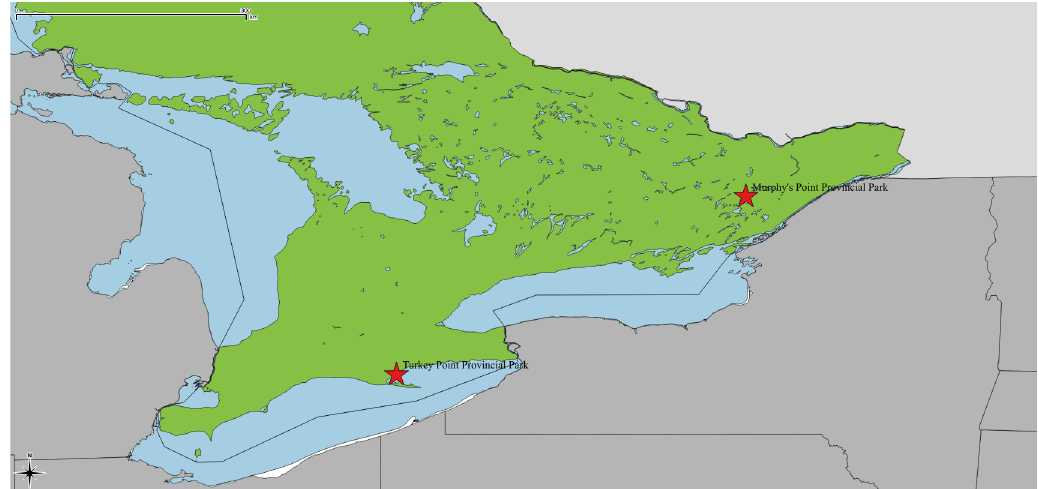
Fig 1. Sites for field sampling. Field sampling was conducted weekly from May to October 2014, alternating between Murphy’s Point Provincial Park and Turkey Point Provincial Park (red stars). Base vector layers were accessed through the Scholars Geoportal at the University of Guelph (http://geo2.scholarsportal.info) from the Ontario Ministry of Natural Resources (province and water) and DMTI Spatial Inc. (Canada and United States of